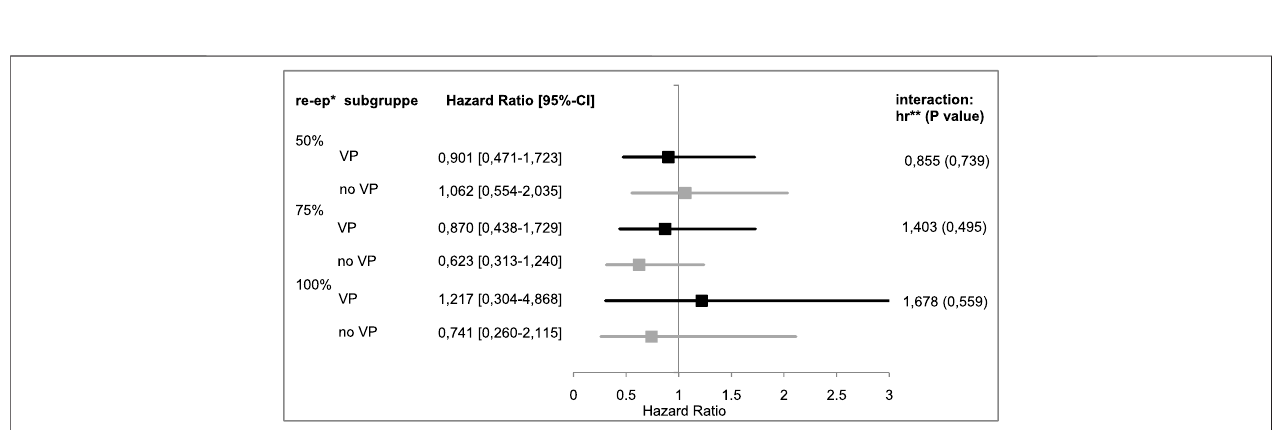
FIGURE6| Hazardratiosofsubgroup “ VP ” vs. “ noVP ” .*re-ep=re-epithelializationlevel;**hr=hazardratio;representsthetherapeuticeffectofEPOwithits95% ¬ con fi denceinterval inthe subgroup, anhr < 1represents anegativetherapeutic effect forthepatientswhoreceivedEPO.Theinteraction effectsarelisted ontheright by the hr, including p -values.